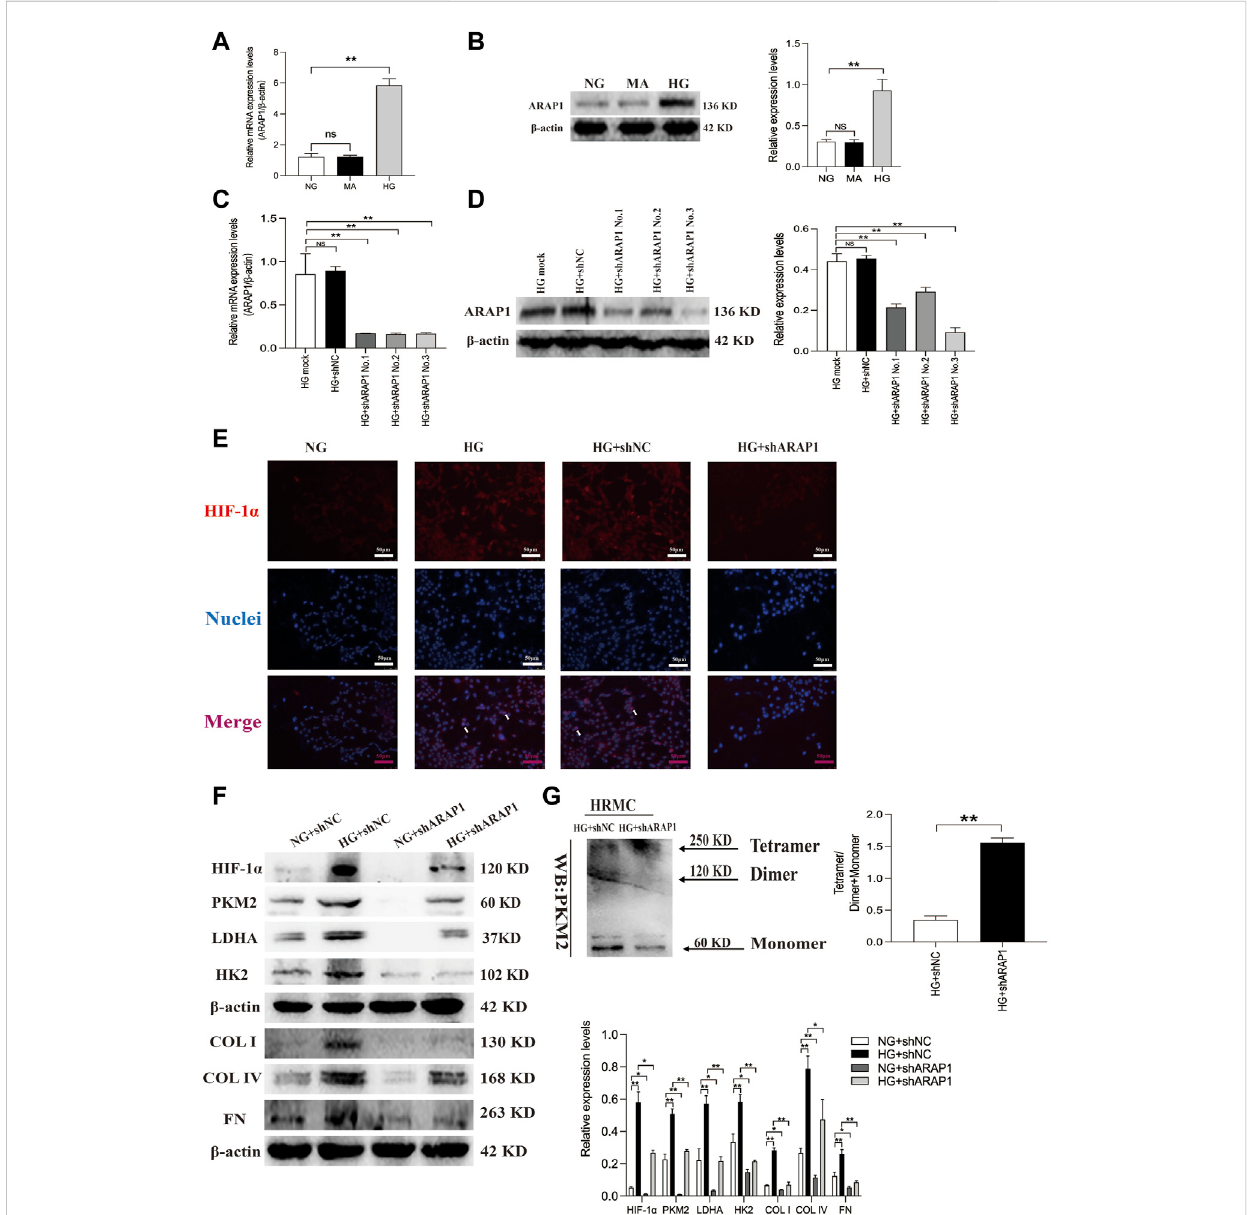
FIGURE 4 ARAP1 knockdown inhibits high glucose-induced dimeric PKM2 expression, HIF-1 α nuclear accumulation, pro- fi brotic responses and aberrant glycolysis, while partly restore tetrameric PKM2 formation in human glomerular mesangial cells. (A,B) qRT-PCR and Western blot analysis showed that themRNAandproteinlevelsofARAP1wereupregulatedinHGgroupcomparedwithNGgroup andMAgroup. (C,D) Forty-eighthoursaftertransfection ofARAP1shRNA(3,000 ng)intheHGgroupin6-wellplates,theARAP1knockdownef fi ciencywasexaminedbyqRT-PCRandWesternblotanalysis. (E) HIF-1 α was assessed by immuno fl uorescence after treatment with high glucose or ARAP1 shRNA (×400). Bar = 50 μ m. Arrows indicate positive staining. (F) Forty-eight hours after transfection of ARAP1 shRNA in the NG group and HG group, the protein expression of HIF-1 α , PKM2, LDHA, HK2, COLI,COLIVand FNwasexaminedbyWesternblotanalysis. (G) Cross-linkingdetectionofPKM2inhumanglomerularmesangialcells.Inall panels,the data are representative of at least three independent experiments. Data are presented as the mean ± SD. * p < 0.05, ** p < 0.01, NS, not signi fi